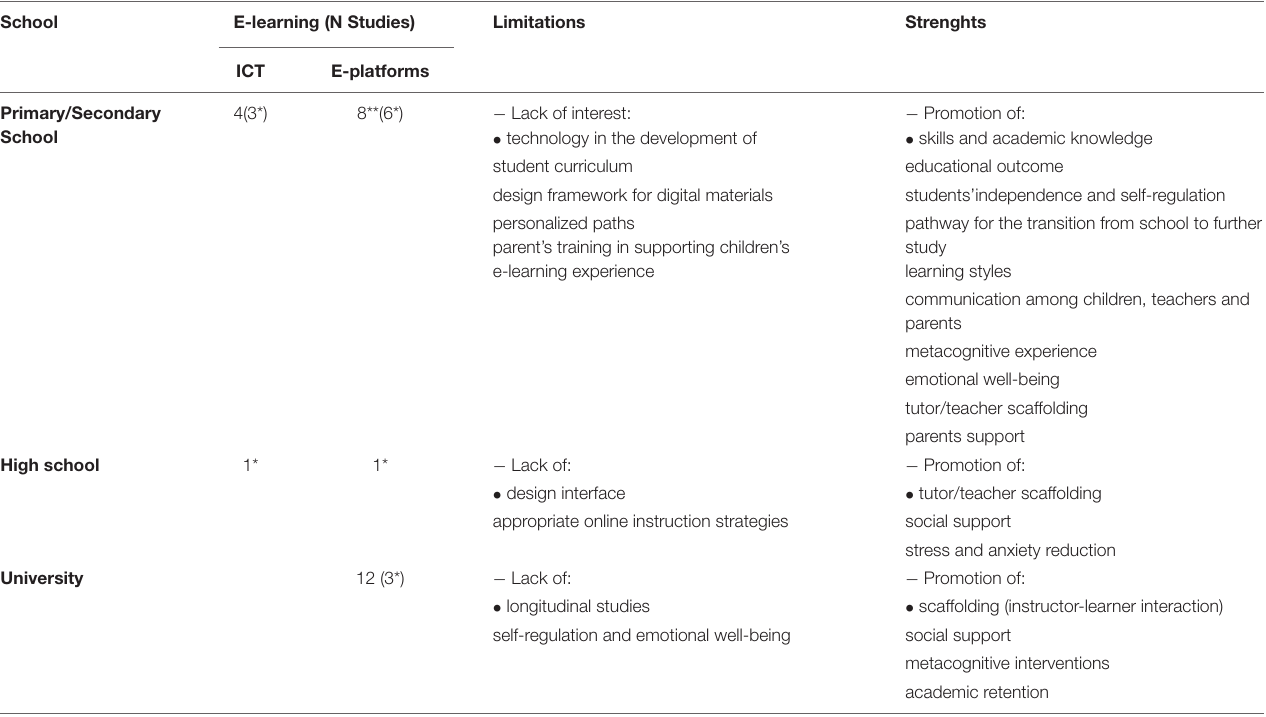
TABLE 2 | Papers which met the inclusion criteria in the school setting analyzed according to Bjekic et al.